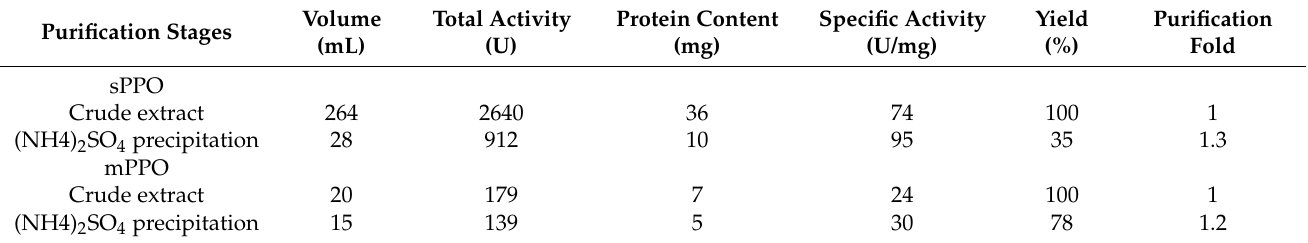
Table 1. Partial purification of sPPO and mPPO from ‘HuJingMiLu’ peach fruit.